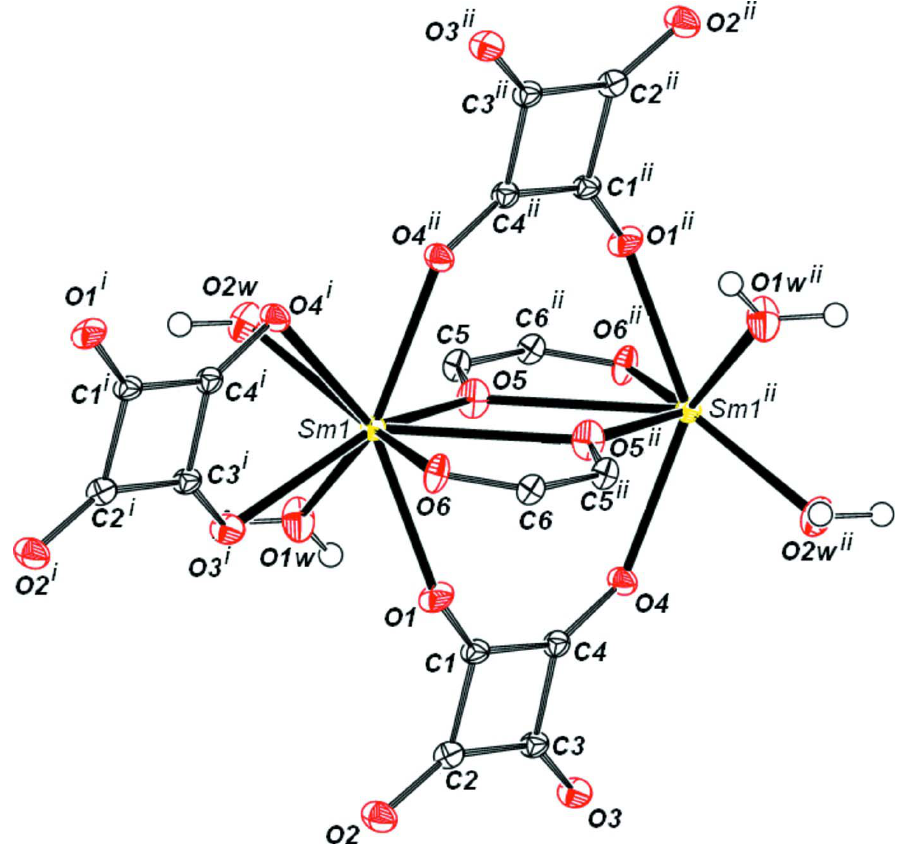
View of the molecular geometry of the title compound with the atom-labelling scheme. Displacement ellipsoids are drawn at the 50% probability level. H atoms are represented as small spheres of arbitrary radii. [Symmetry codes: (i) x-1, y, z; (ii) -x, -y+1,